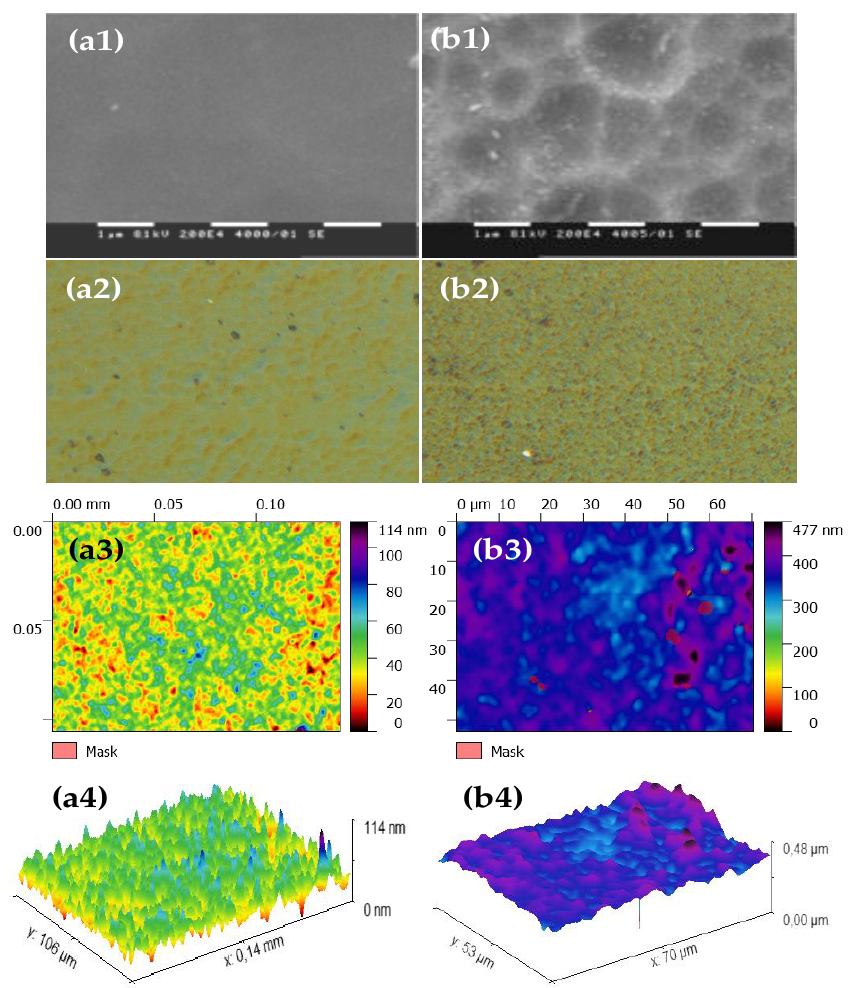
Figure 5. SEM micrographs ( a1 ), optical microscope images ( a2 ) and profilograms (top view ( a3 ) and profile view ( a4 )) of fly ash zeolite thin films (FAZTFs) obtained at di ff erent crystallization durations: ( a ) hydrothermal activation for 12 hours; ( b ) hydrothermal activation for 20 hours.